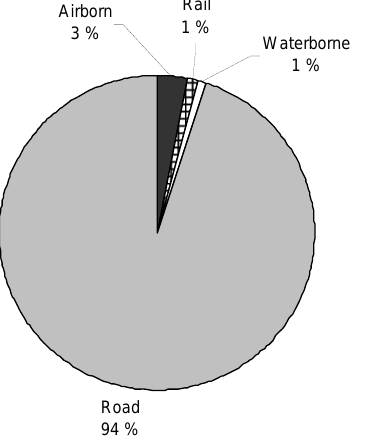
Fig 7. Modal split in energy consumption of freight transport, in EU-25 (in 1000 tonnes of oil equivalent) [18] Fig 5. Share of transport modes from the total external costs of freight transport (EU-17)